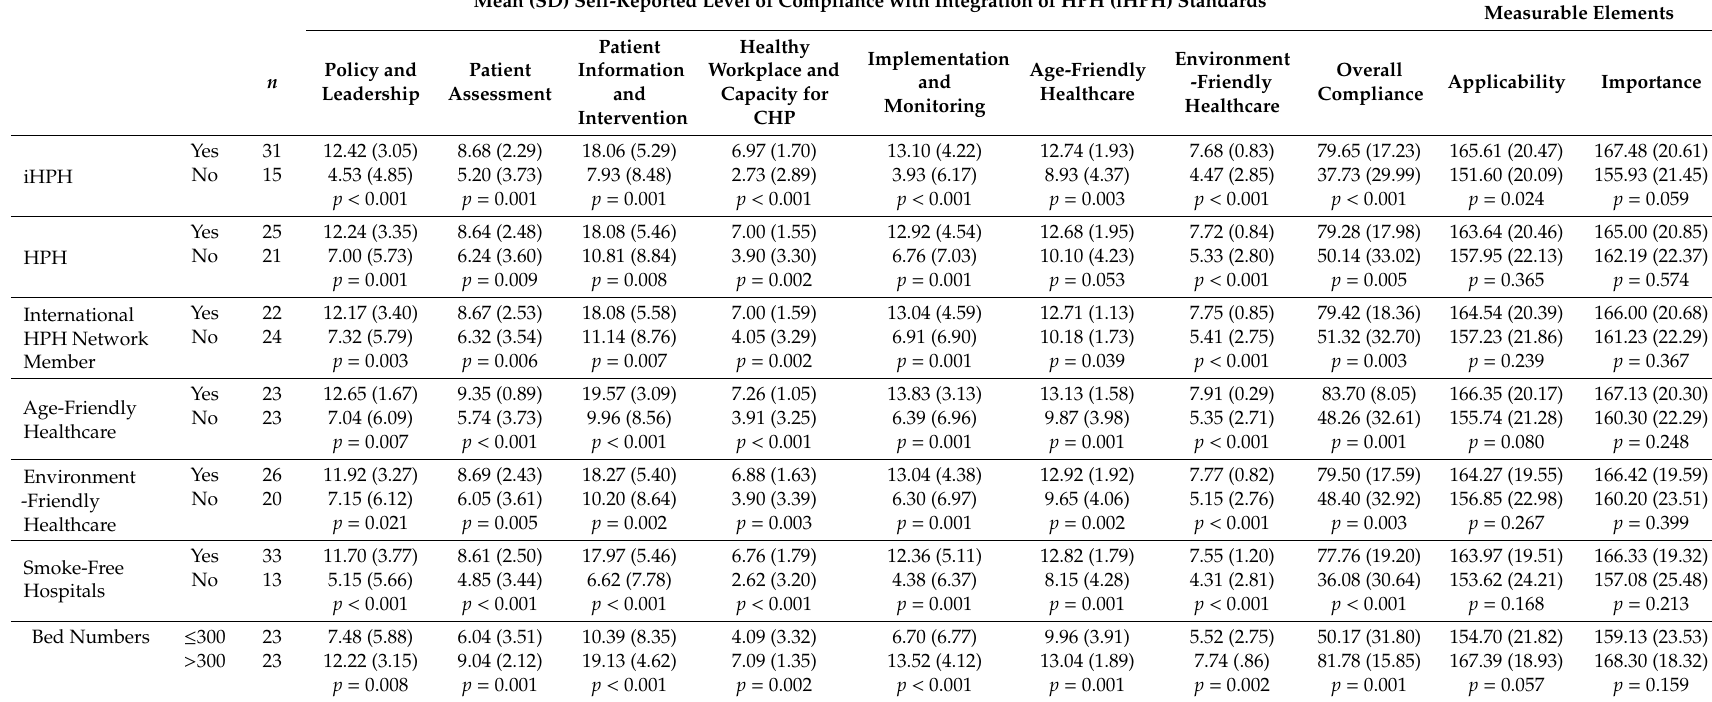
Table 5. Compliance and assessment of measurable elements by hospital